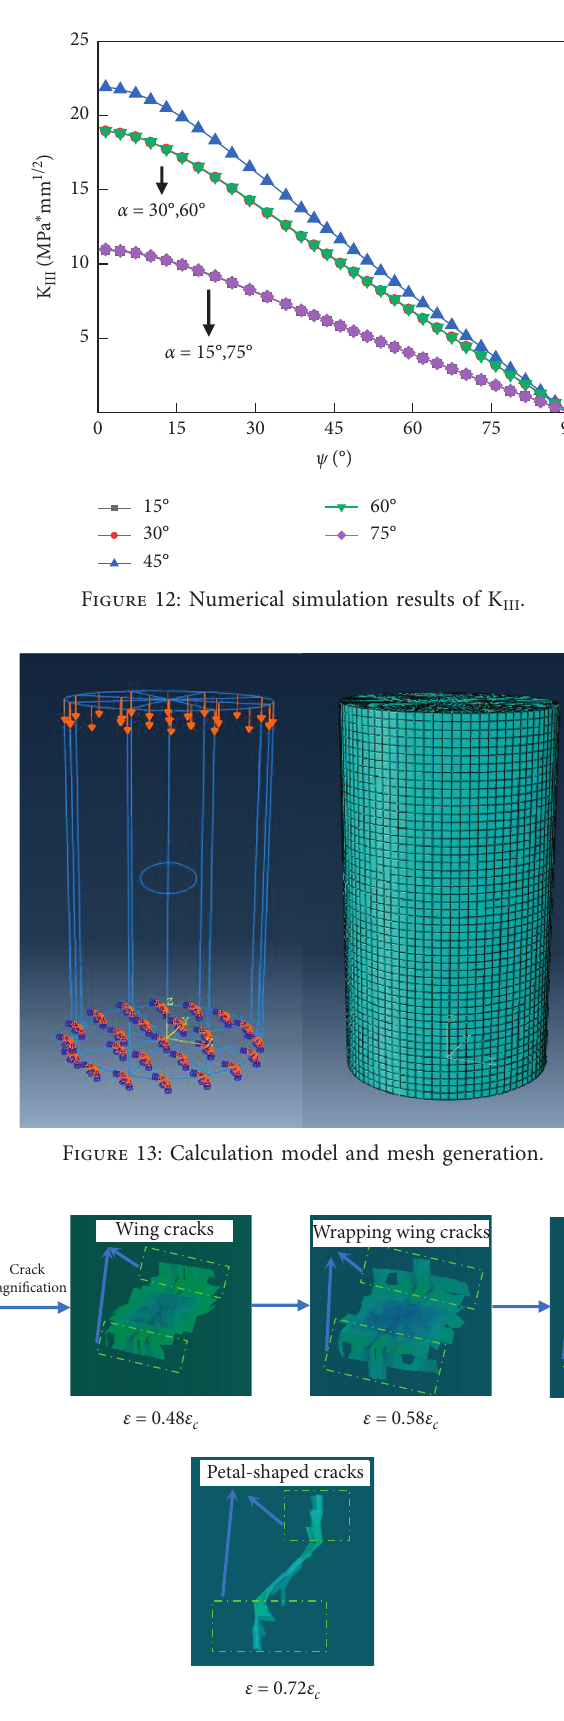
Figure 14: Diagram of 3D preexisting crack growth process.